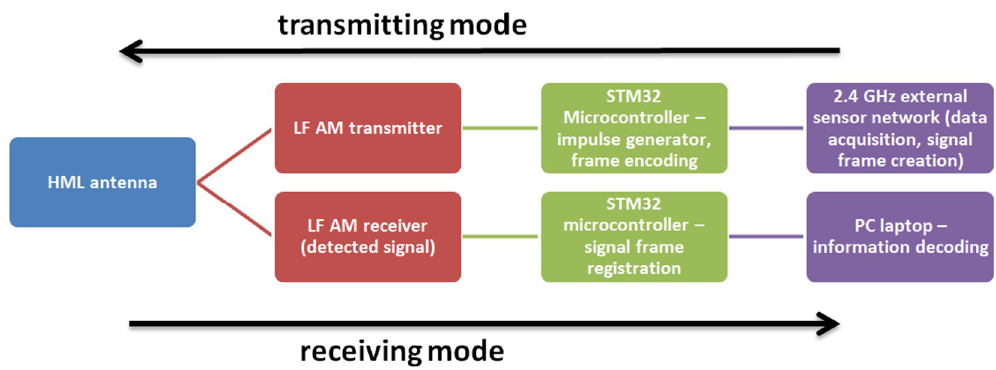
Figure 1. A schematic of the IGLUNA 2019 initial communication system. The HML (Horizontal Magnetic Loop) antennas were designed as both transmitting- and receiving antennas, as the receiving subsystem was to be operated continuously and simultaneously with the transmitting subsystem, the receiver would detect both the self-transmitted and incoming transmissions.